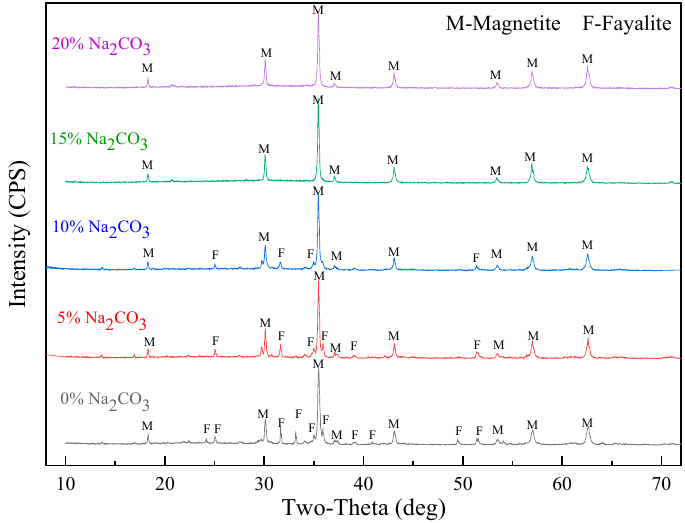
Figure 10. XRD spectra of Cu slag with different amounts of Na 2 CO 3 (CPS — Count per second) .